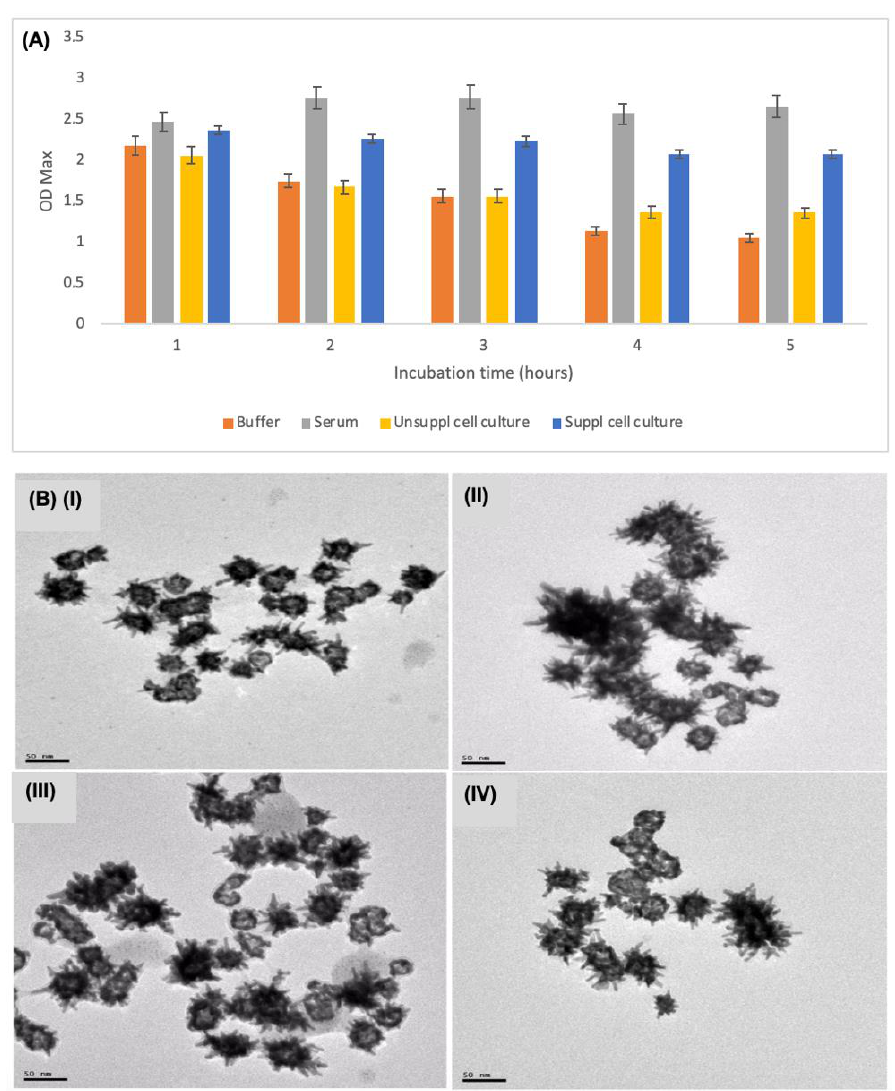
Figure 2. ( A ) The stability of AuNSs–Cys–GOx bioconjugates in di ff erent media based on the UV-vis spectroscopy over a 24-h period. ( B ) TEM images of the AuNSs–Cys–GOx bioconjugates in di ff erent sample matrices: (I) in MES bu ff er; (II) in serum; (III) in unsupplemented cell media; and (IV) in supplemented cell